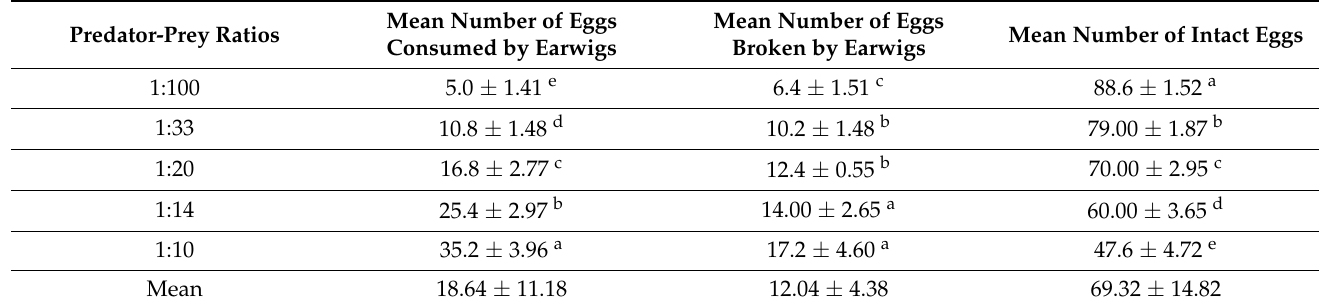
Table 1. The number of eggs consumed by adult earwigs present in each ratio after 24 h, under laboratory conditions.